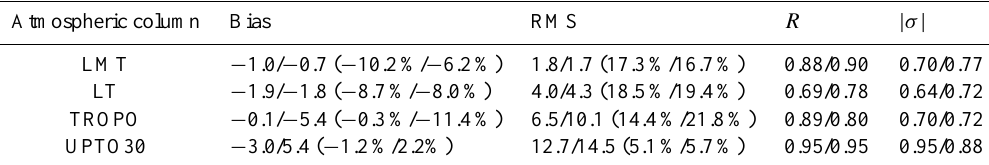
Table 4. Comparison of IASI only (left) and GOME-2 only (right) ozone retrievals against ozonesonde measurements smoothed by averaging kernels of the retrievals. The same conventions, pixels and ozonesondes as in Table 2 are used. Comparison of IASI only/GOME-2 only ozone retrieval vs. ozonesondes smoothed by the retrieval AVK